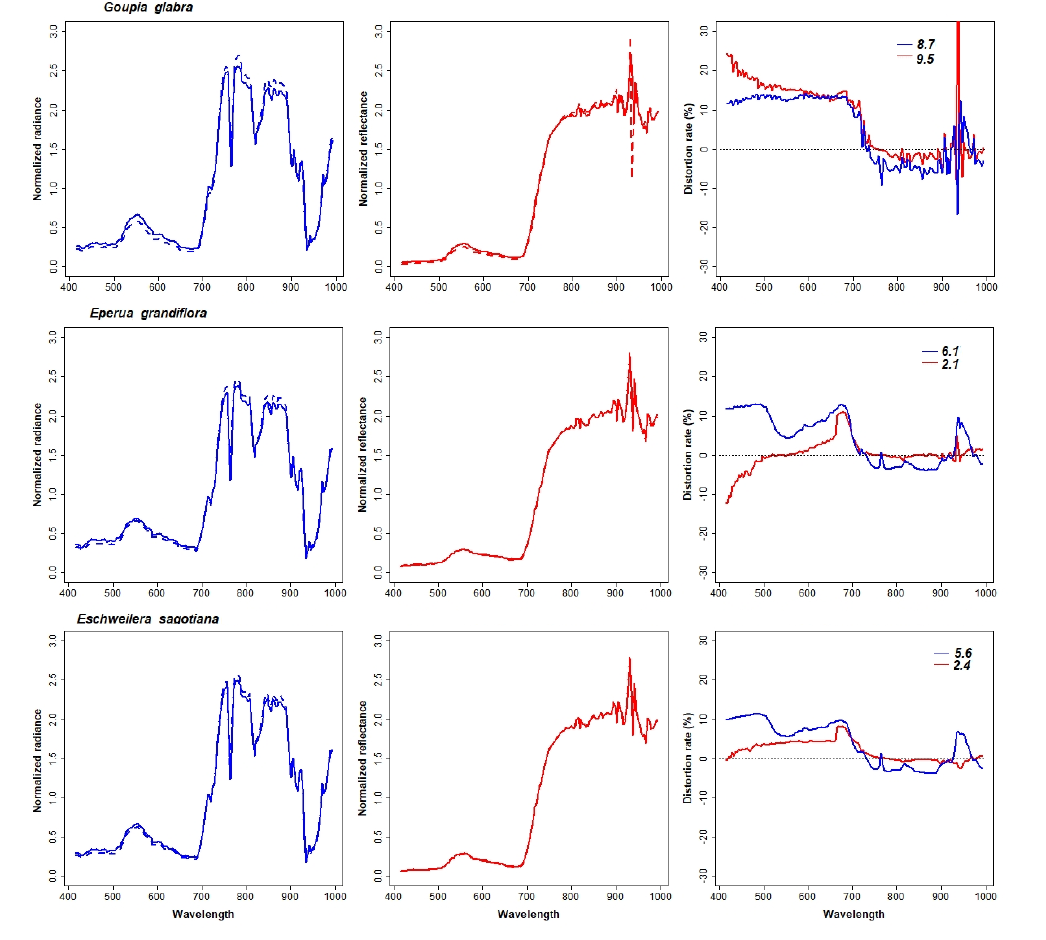
Figure 6. Mean normalized radiance (first column) and mean normalized reflectance (second column) for 3 arbitrarily selected species. Solid line stands for date 1, dotted line for date 2. Third column represents normalized difference of average spectrum using the two acquisition dates. Blue line is for L1b filtered and normalized spectrum and red line for L1c SHAOT, filtered and normalized spectrum. The mean distortion rate (over all wavelengths) is given in the upper right corner for each